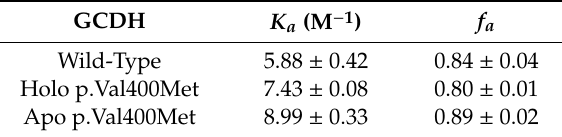
Table 1. Modified Stern–Volmer plot parameters of acrylamide quenching of tryptophan (Trp) fluorescence in GCDH.